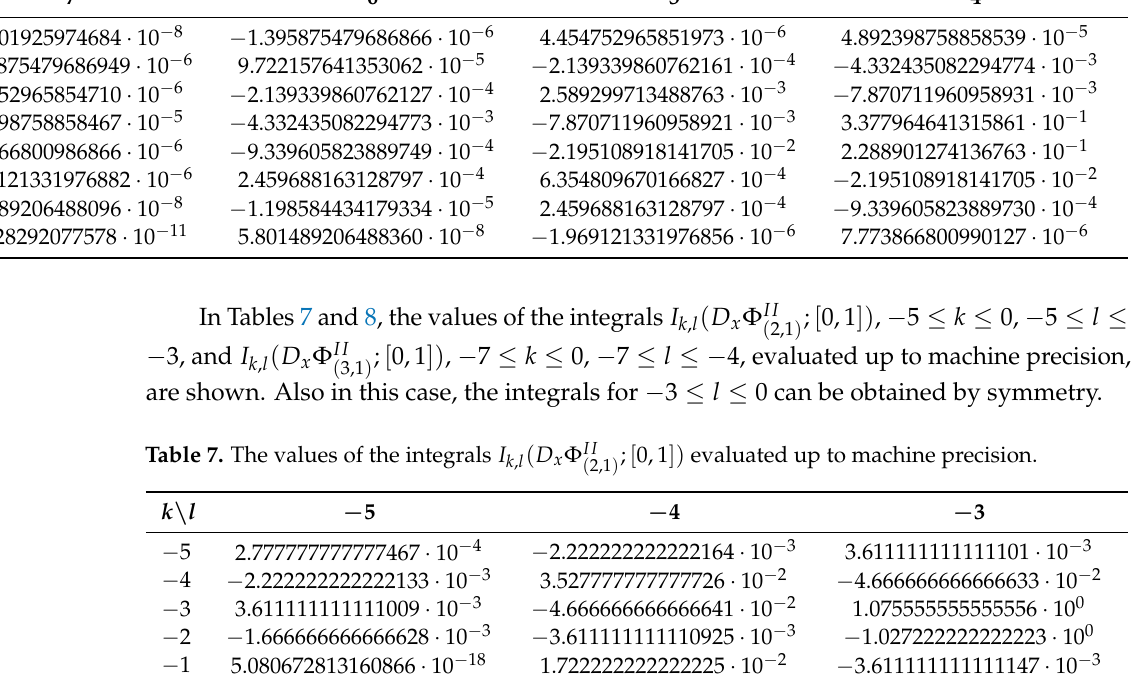
Table 6. The values of the integrals I k , l ( Φ II